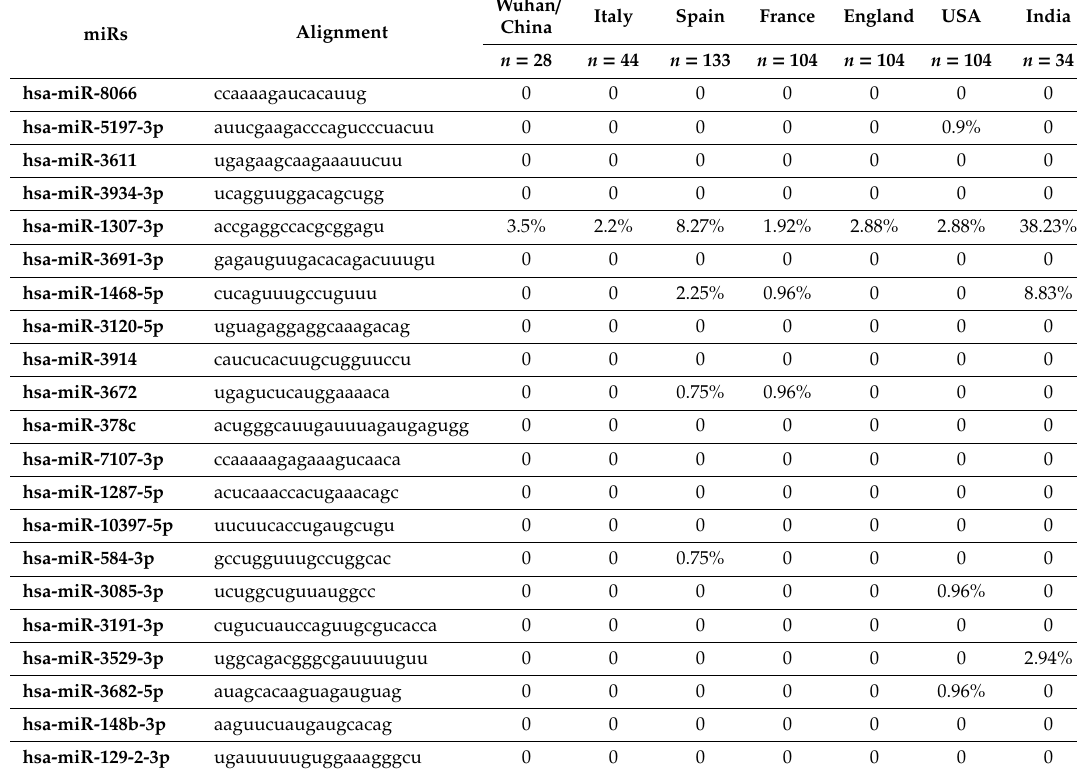
Table 3. The mutational comparison of selected miRs found on the Wuhan genome compared to other SARS-CoV-2 strains isolated from di ff erent geographical regions. % represents the number of viral genome sequences with a single base change in that miR sequence. n = number of viral genomes